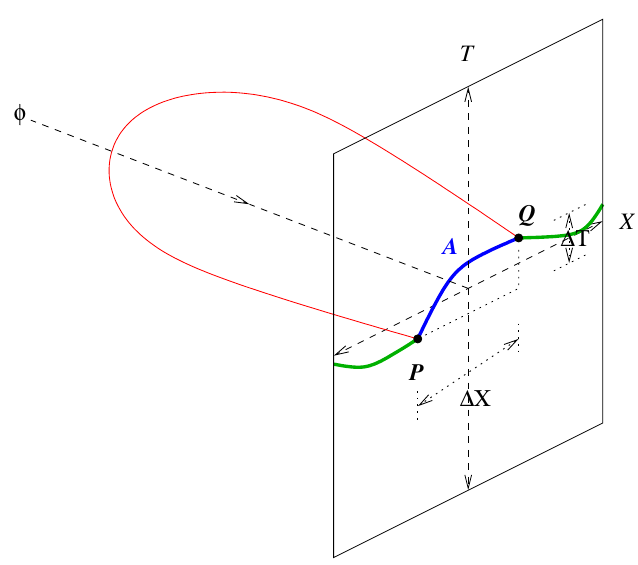
Figure 2 . The U-shaped red curve in the figure is the schematic illustration of the Ryu-Takayanagi surface anchored at points P and Q on the boundary. The points P and Q are spacelike separated on the X, T plane. The curve in blue is the interval A and its complement A is the curve in